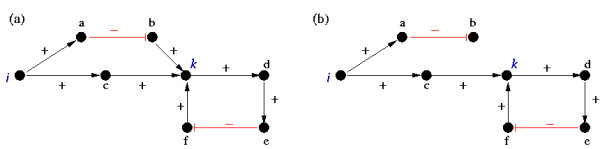
Two examples of simple signed directed graphs (interaction graphs). Graph (b) is the same as graph (a) except that the negative arc from b to k has been removed.